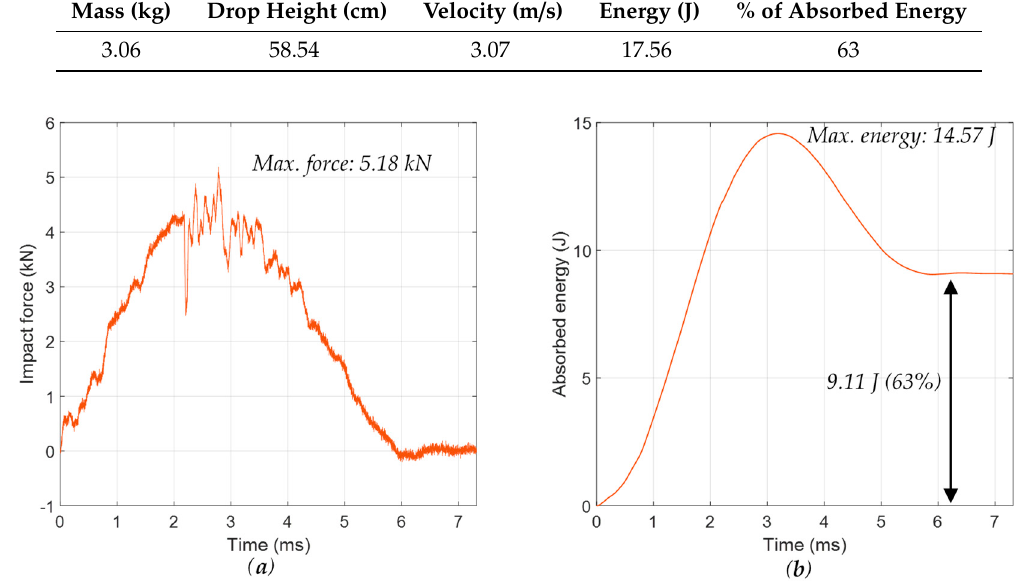
Figure 15. Force–time history and absorbed energy of the [ − 45/90/+45/0] 3S coupon: ( a ) force history; ( b ) absorbed energy history.